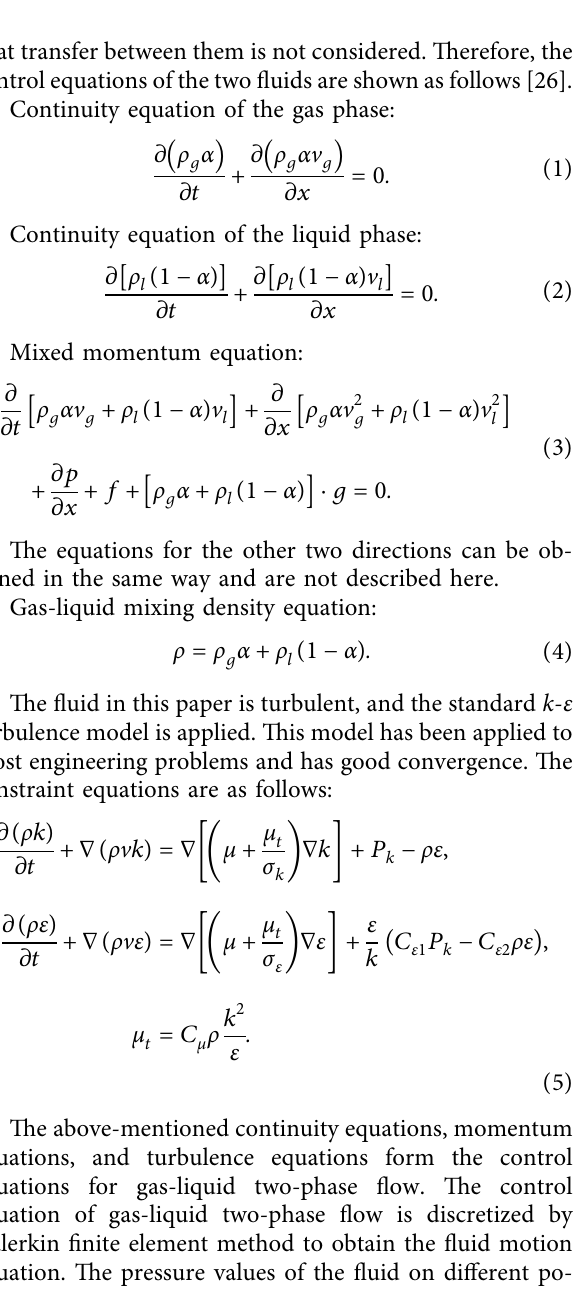
Figure 2: A simplified model of the drill string